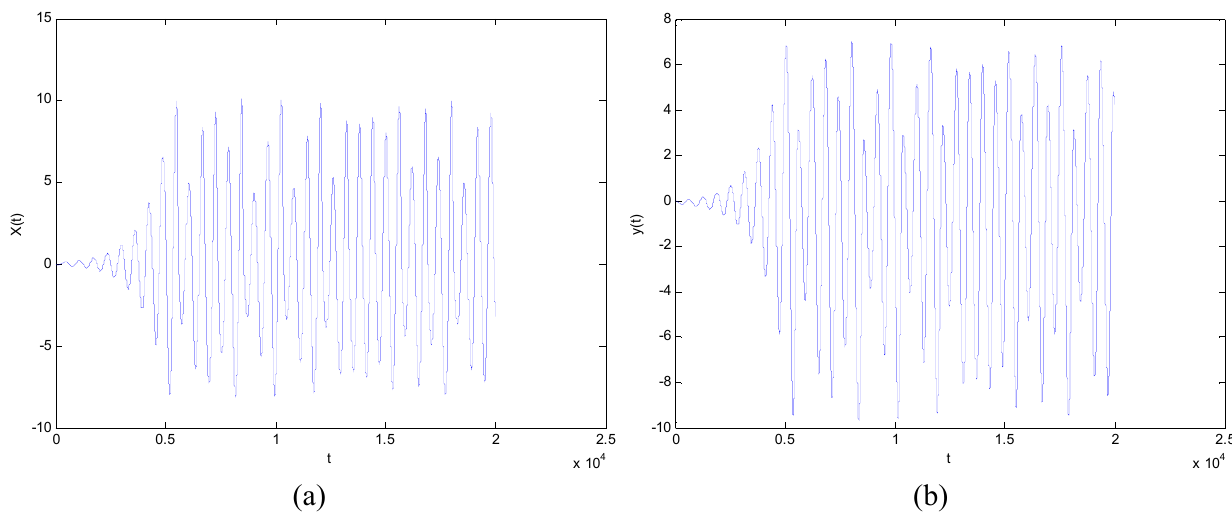
Figure 5. Chaotic sequence of ( a ) x ( t ) and ( b ) y ( t